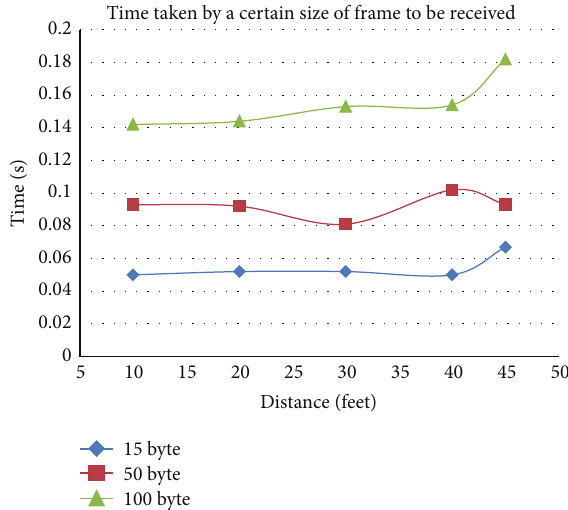
Figure 3: Frame receiving time by increasing distance for different sized